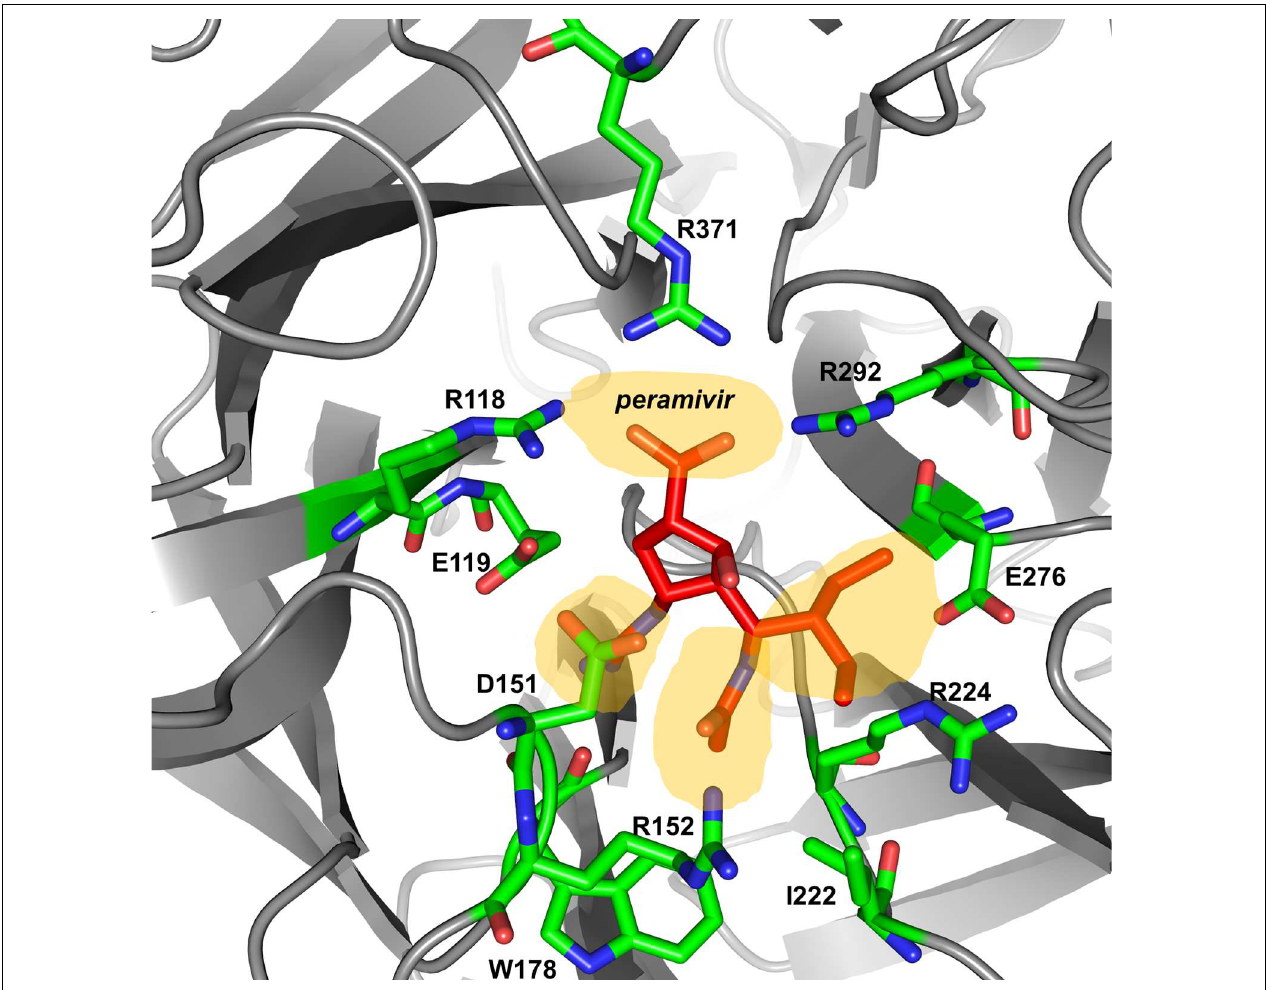
FIGURE 2 | Peramivir bound to influenza A/H7N9 neuraminidase. Crystal structure of peramivir and influenza A/H7N9 neuraminidase complex (4 MWV). The four binding pockets of the enzyme active site are shown in yellow